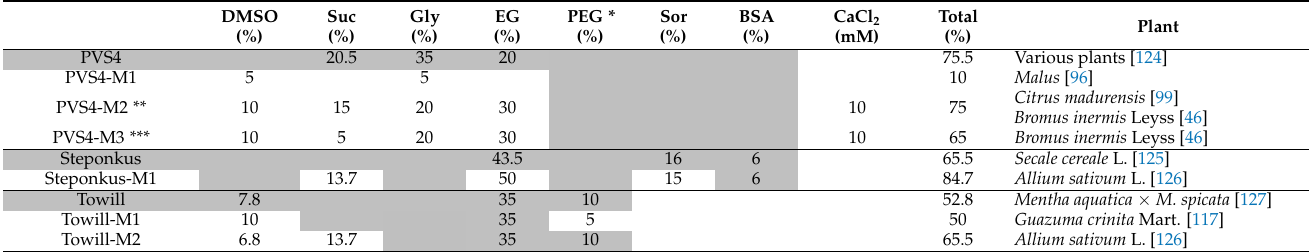
Table 5. Plant Vitrification Solution 4 (PVS4), Steponkus’, Towill’s and their modifications in concentration, composition, and some omitted and added substances in % ( w / v